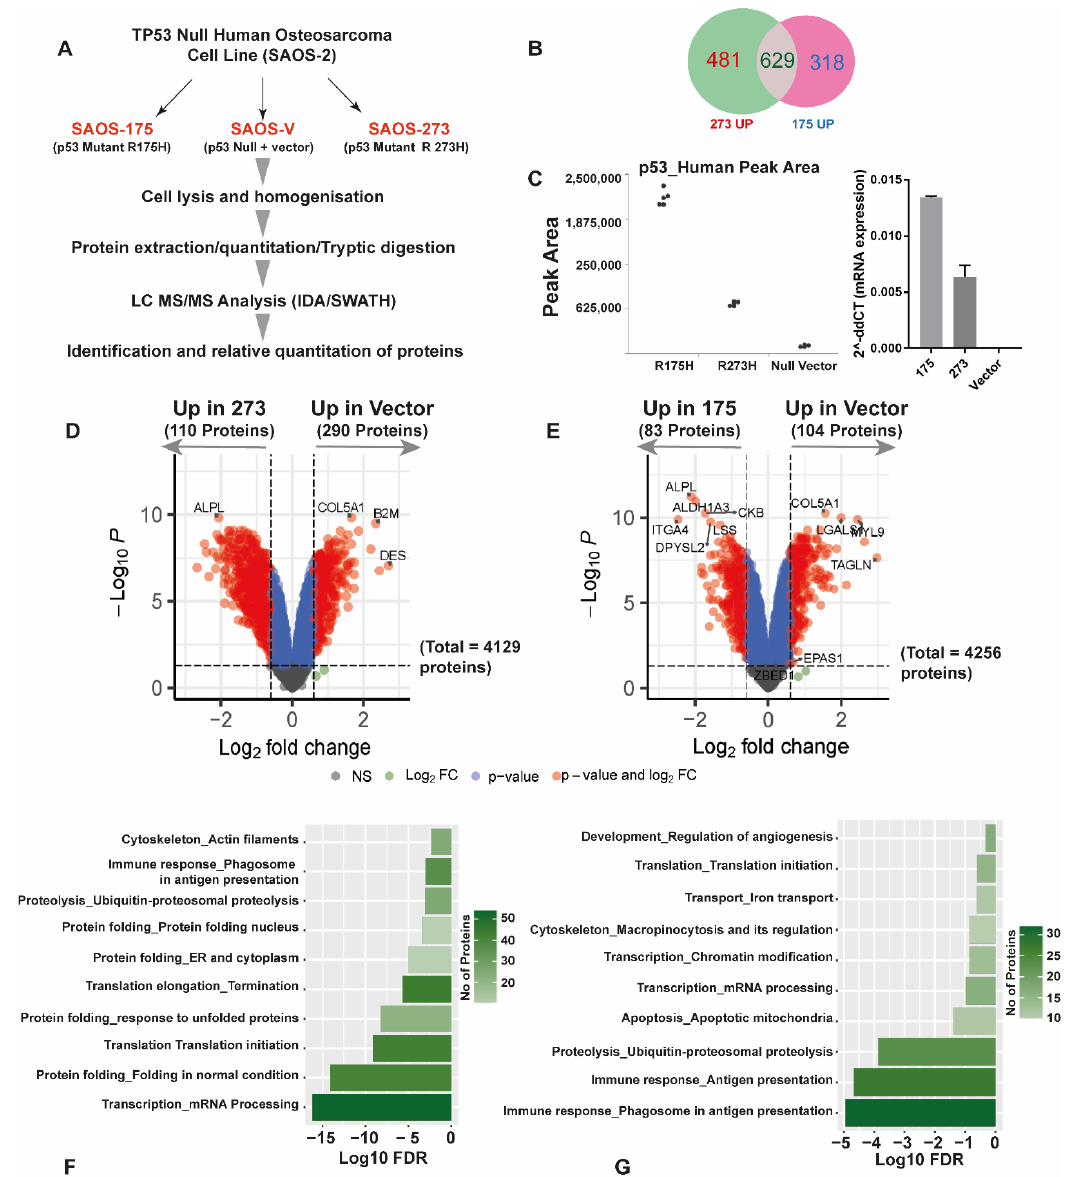
Figure 2. Label-free global quantitative SWATH proteomics revealed significant proteome changes in the SaOS-R175H and SaOS-R273H cell lines compared to SaOS-V. ( A ) Workflow followed for generating quantitative proteomics data; ( B ) Venn diagram showing common and unique proteins differentially upregulated in R273H and R175H mutants compared to vector control; ( C ) P53 levels in each cell line by mass spectrometry and qRT PCR; ( D ) volcano plot showing differentially ex- pressed proteins in SaOS-R273H compared to SaOS-V cells (significant proteins are highlighted in